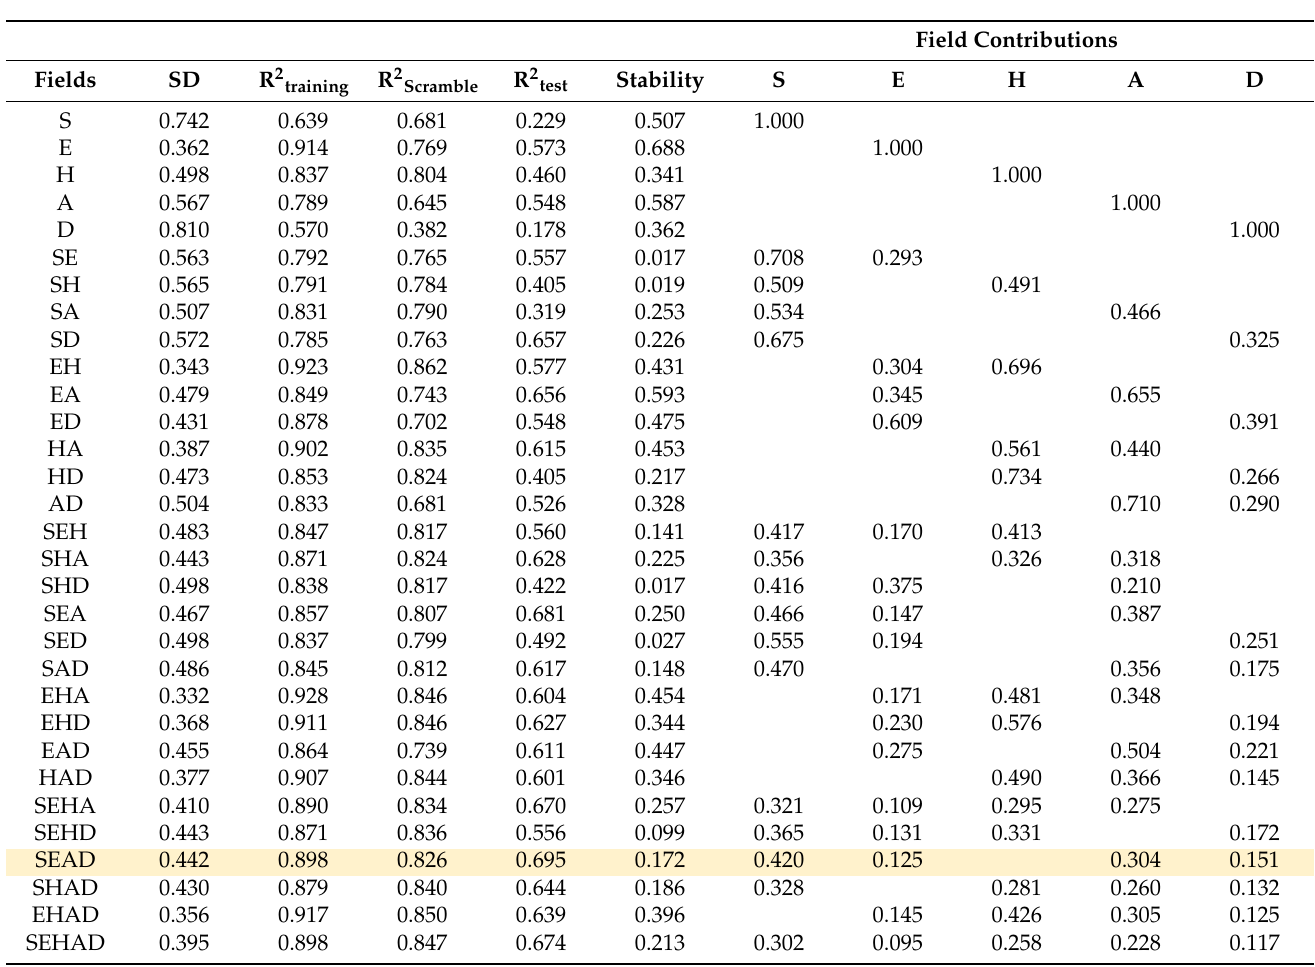
Table 2. Summary of statistical results from Gaussian field quantitative structure-activity relationship (GFQSAR) and field contributions.